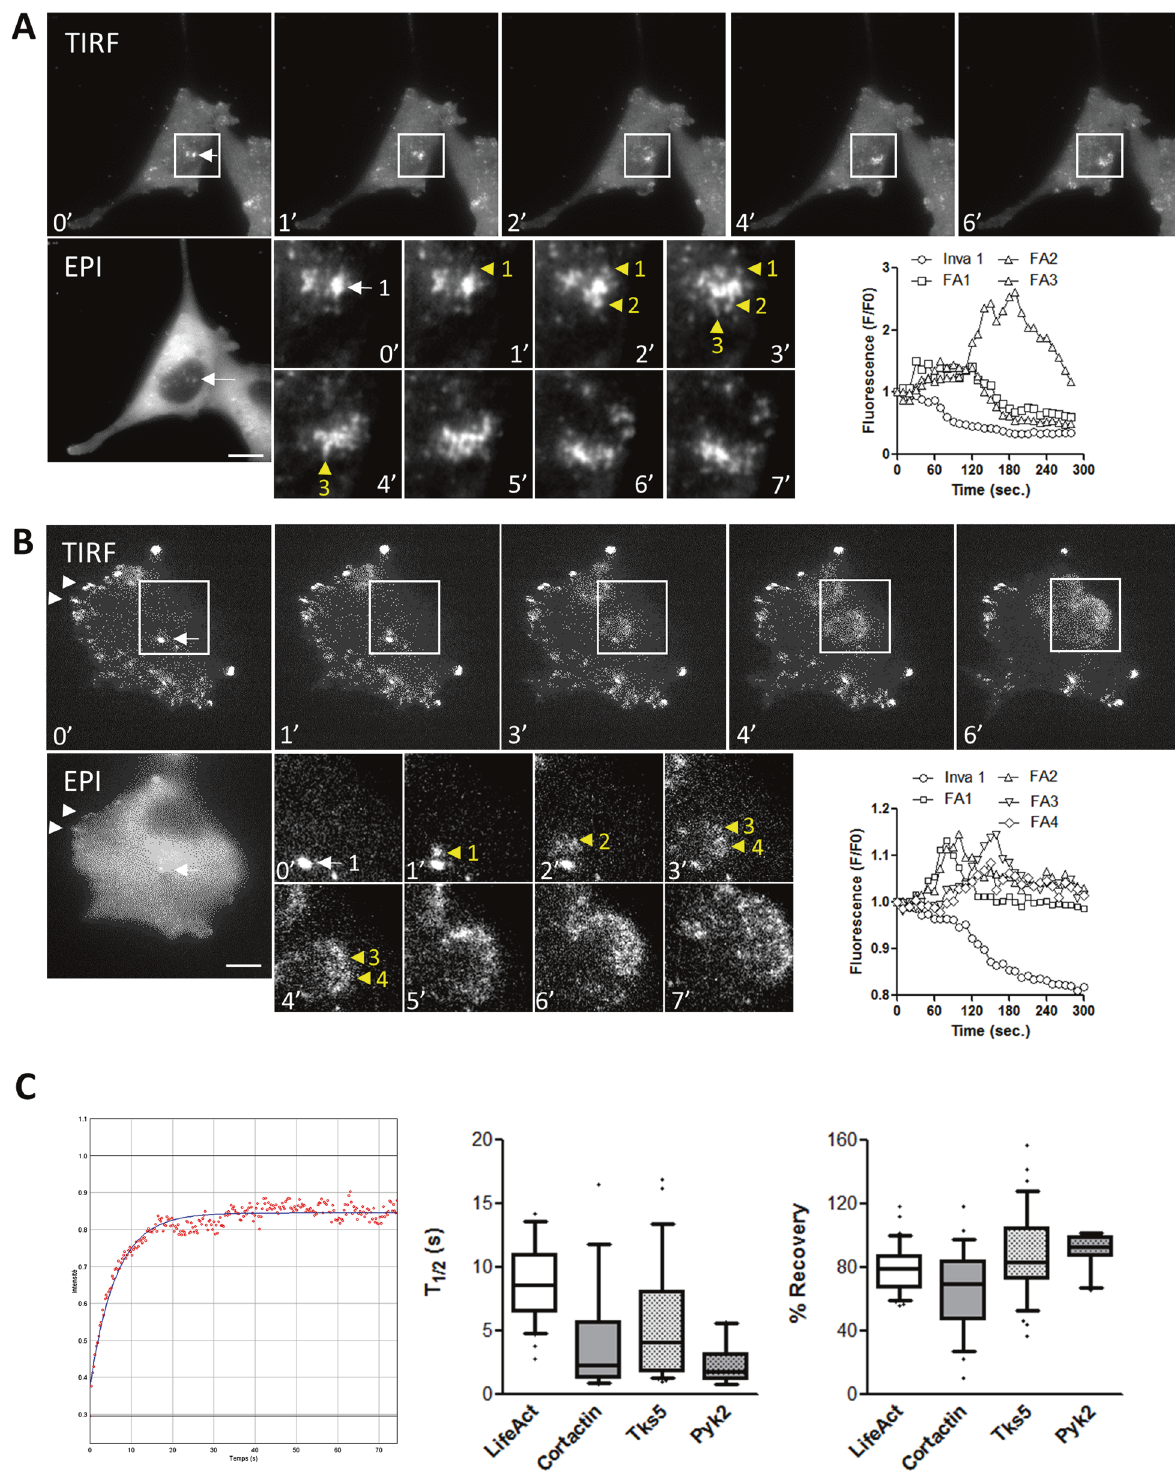
Fig. 6 Analysis of invadopodia dynamics and protein dynamics at invadopodia. A375 cells expressing either Cortactin-dsRed ( A ) or Pyk2- GFP ( B ) were imaged by dual Epi fl uorescence/TIRF mode at 1 image/10 s during 1 h. Insets show magni fi ed views of invadopodia (white arrows). One image in epi fl uorescence (EPI) is shown for each condition to help visualise the cortical location of invadopodia. Note the transformation of dot-like invadopodia into focal complexes (yellow arrowheads) in cells expressing cortactin ( A ) and Pyk2 ( B ). Representative time-lapse images are shown from 27 to 37 cells. Graph represent normalised fl uorescence intensity over time at invadopodia and nascent adhesions. Scale bar: 10 µm. C Analysis of protein dynamics at invadopodia by FRAP. Left, a typical recovery curve of Tks5-GFP at invadopodia is shown. Middle, box chart represent the mean t 1/2 and whiskers the 10 – 90 percentile from 10 to 35 cells analysed per condition. Right, box chart represent the mean % of recovery and whiskers the 10 – 90 percentile from 10 to 35 cells analysed per condition.